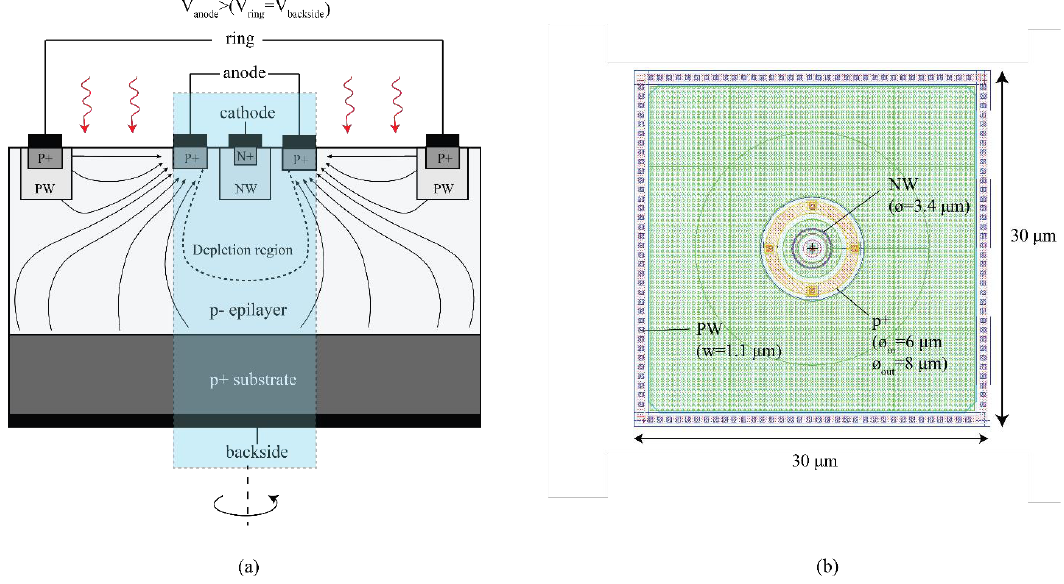
Figure 21. Cross section of CA-SPAD-2, lines with arrows indicate the direction of photo-electrons, the dotted line represents the boundary of the depletion region ( a ) and top-view of the layout of CA-SPAD-2 with dimensions indicated ( b ).